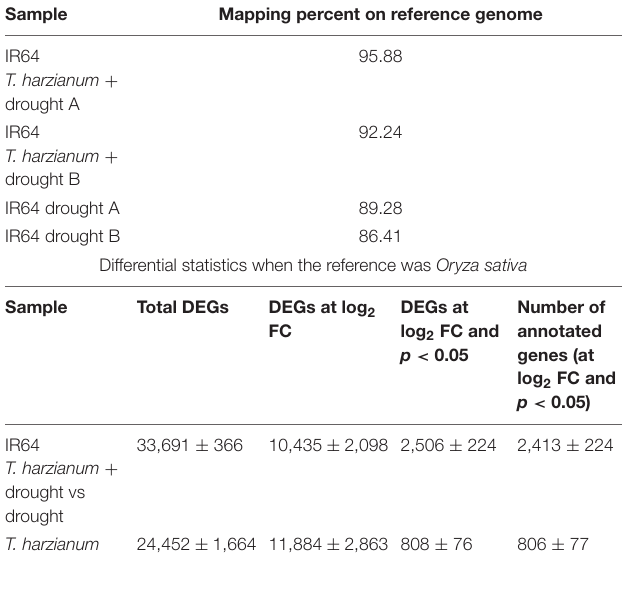
TABLE 1 | Statistics of transcriptome sequencing